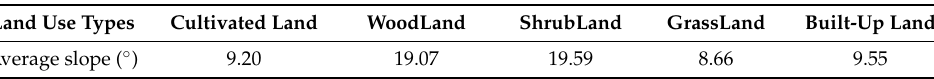
Figure 1. Location and characteristics of the study area: ( a ) the location of the 94 sampling sites in the Luanhe River basin and the land use types; ( b ) catchment (entire upstream catchment above the sampling site); and ( c ) riparian buffer with different widths. Table 1. Average slope of main land use types.